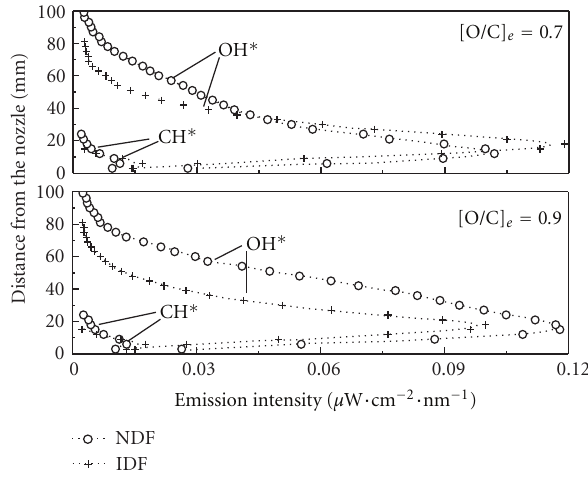
F 8: e comparison of OH NDFs and